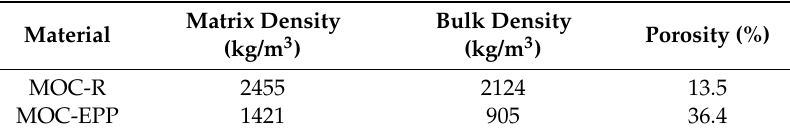
Table 5. Basic structural properties of MOC-based materials.